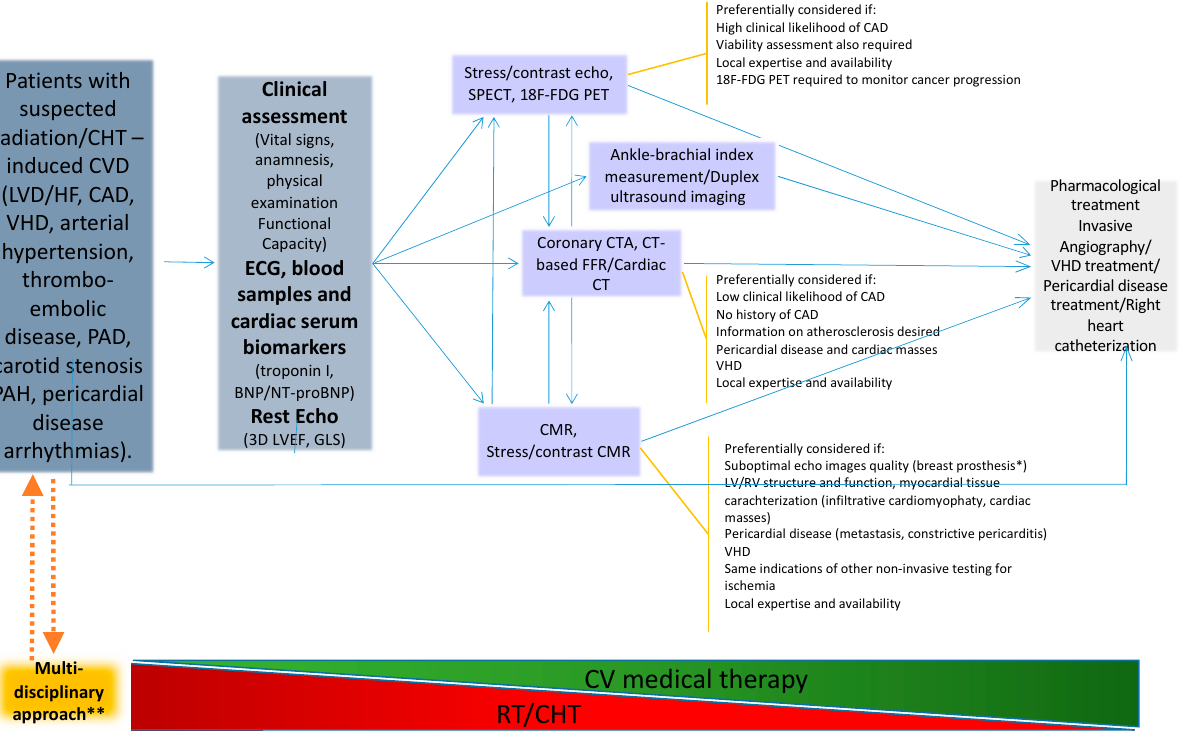
Figure 4. Management of cancer therapy-related CVD: a stepwise approach [2,7,36,38,82–87]. BNP = brain natriuretic peptide; CHT = chemotherapy; CMR = cardiac magnetic resonance; CT = computed tomography; CTA = computed tomography angiography; FFR = fractional flow reserve; CVD = cardiovascular disease; HF = heart failure; GLS = global longitudinal strain; LVD = left ventricular dysfunction; LVEF = left ventricular ejection function; NT-proBNP = N-terminal pro-brain natriuretic peptide; PH = pulmonary hypertension; RT = radiotherapy; VHD = valvular heart disease. * It is important to inquire about the presence of ferromagnetic components if the patient has breast tissue expanders. ** Including cardiologists, oncologists, radiotherapist oncologists, and hematologists.